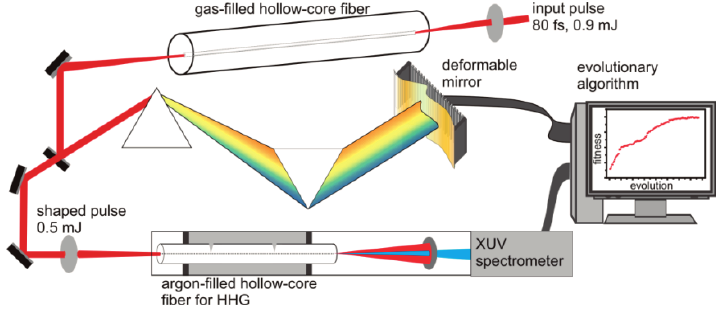
Figure 2. After spectral broadening in a gas-filled hollow-core fiber (HCF) laser pulses are sent through a prism-compressor with a computer-controlled deformable mirror for pulse shaping. Afterwards, the pulses are focused into an argon-filled capillary where they generate high harmonics. These are detected by an extreme ultraviolet (XUV) spectrometer and its signal is used as a feedback for an evolutionary